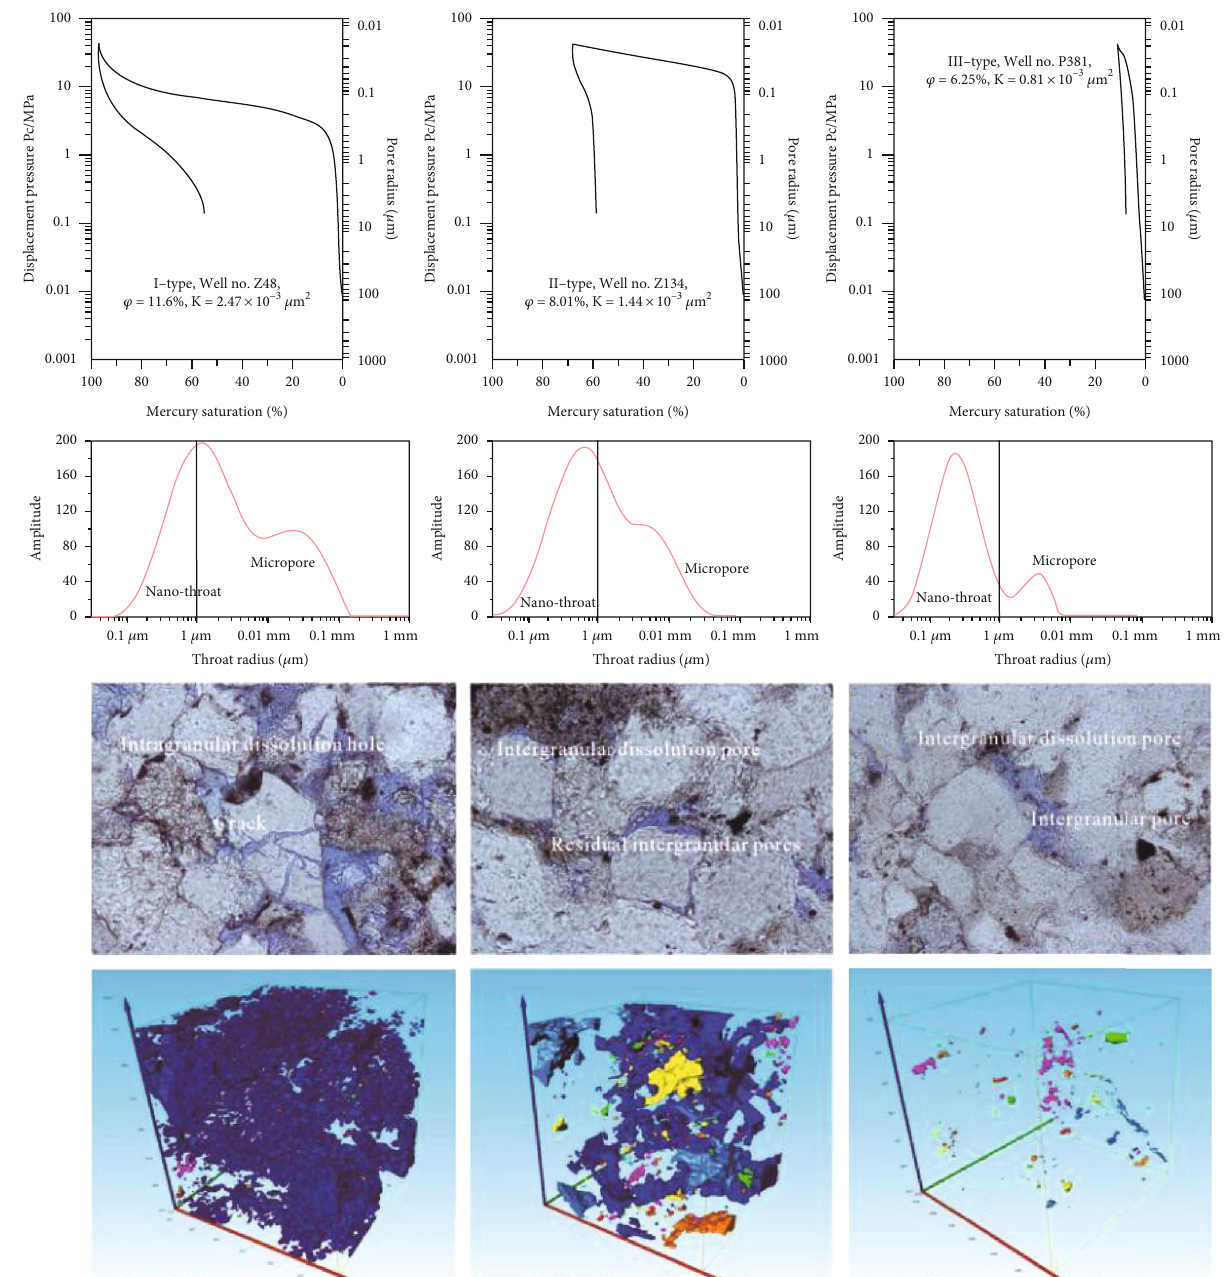
Figure 9: Characters of micropore structure in di ff erent types of tight oil